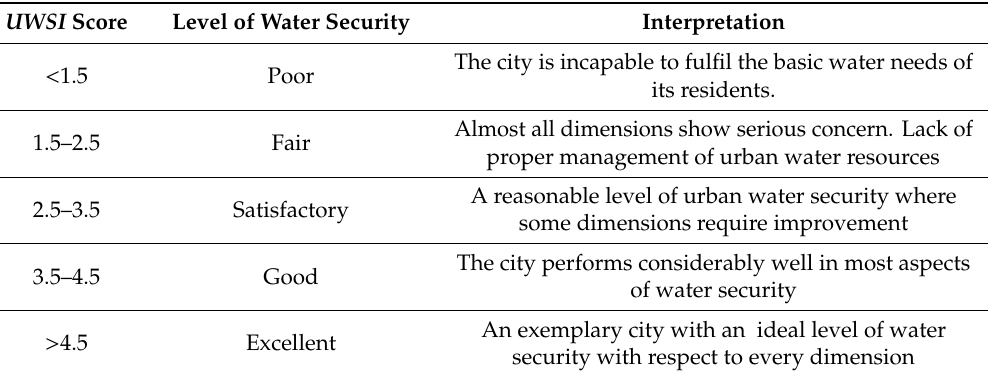
Table 7. Interpretation of UWSI scores.